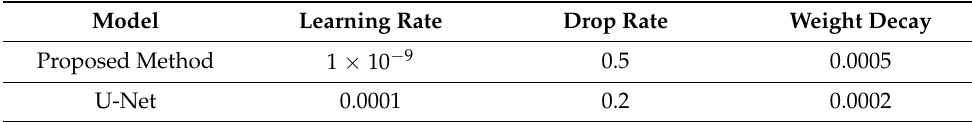
Table 2. Network Parameters